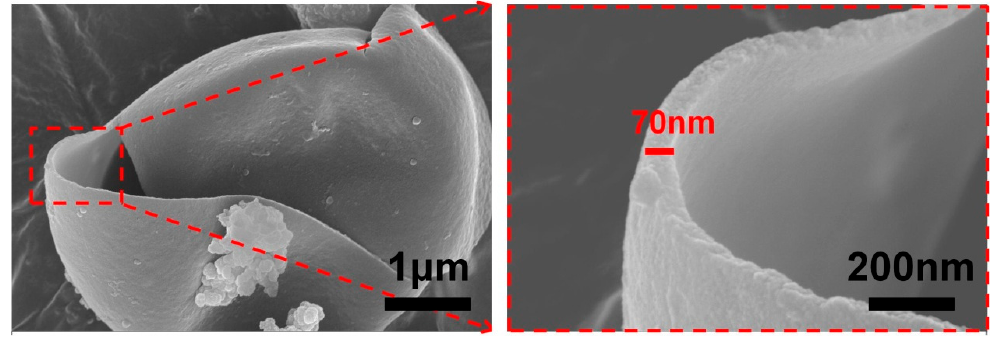
Figure 4. SEM micrographs of broken IPDI microcapsule.